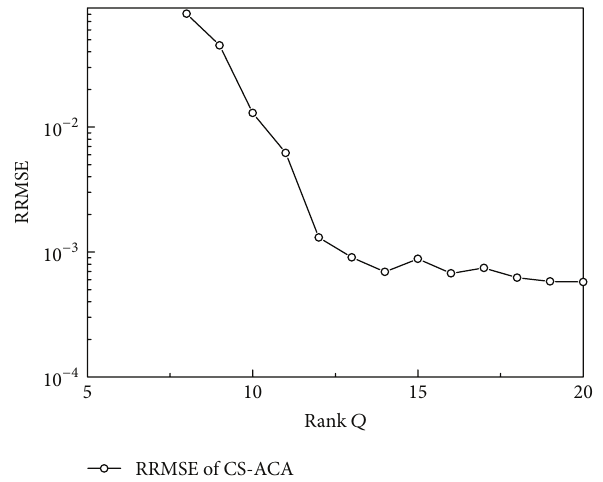
Figure 3: RRMSE of CS-ACA method for Almond.